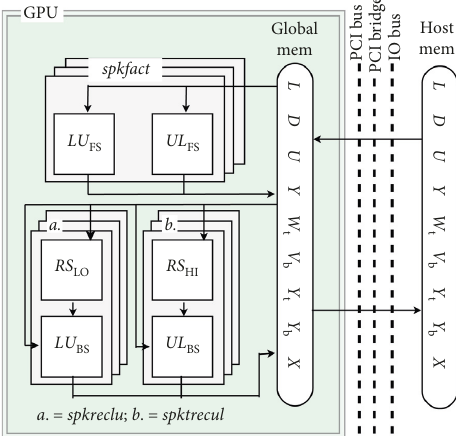
Figure 5: The GPU truncated SPIKE OpenCL kernels spkfact , spkrecul , and spkreclu , with the execution path and data de- pendencies shown. All kernels are executed as an NDRange of work